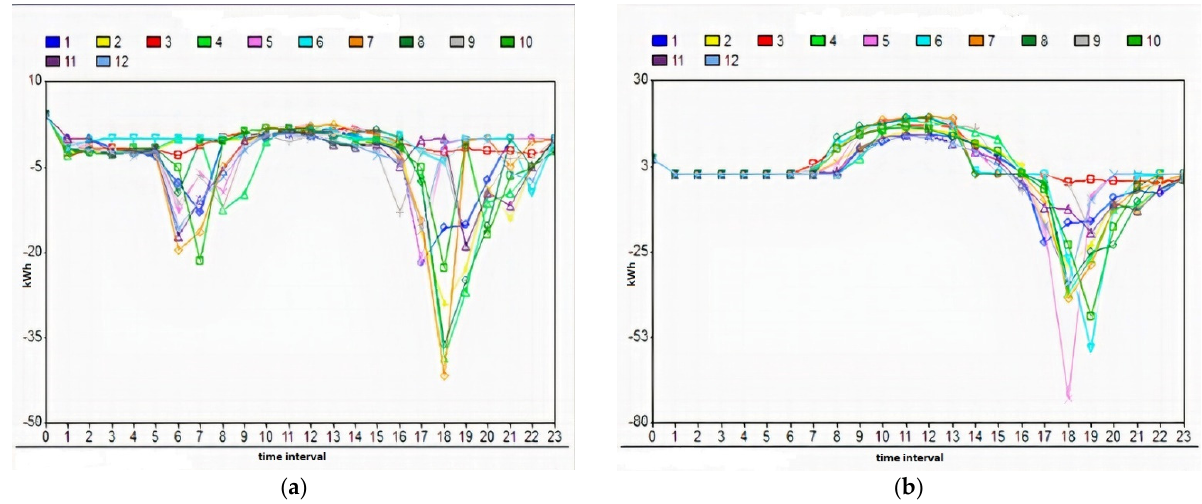
Figure 3. ( a ) Daily battery exchange within the micro-grid for every month for case study I; ( b ) Daily battery exchange within the micro-grid for every month for case study II–III.